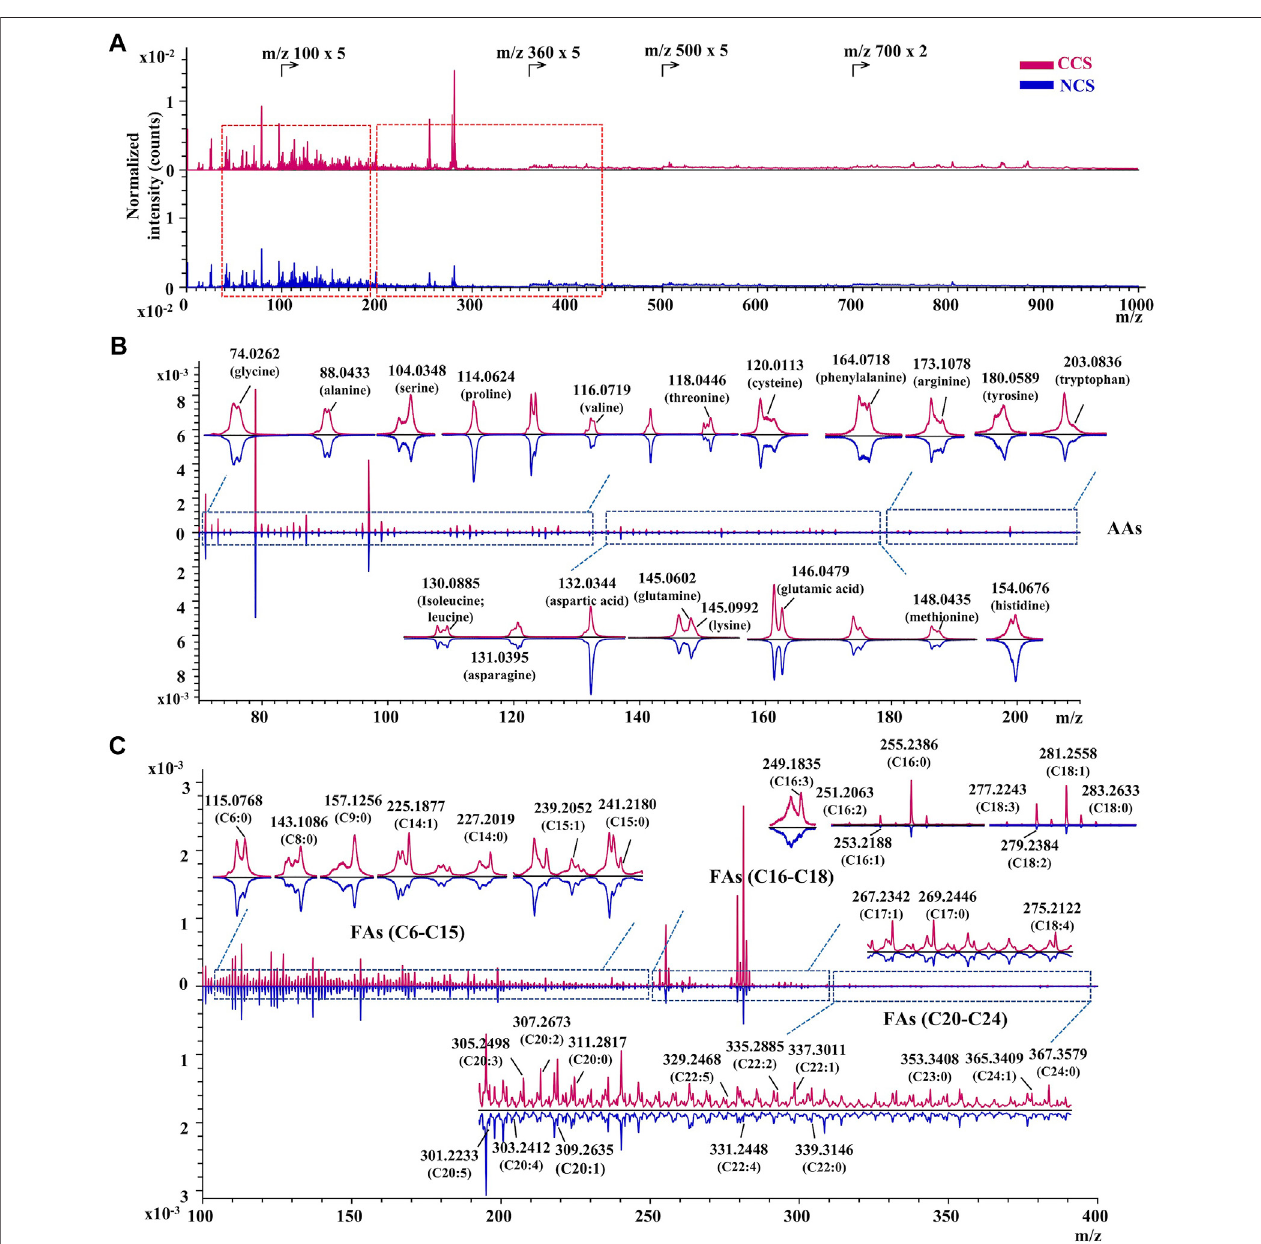
FIGURE 4 | The TOF-SIMS spectra of CCS and NCS samples in negative mode. (A) The representative spectra of CCS (No. 4 in red) and NCS (No. 14 in blue) samples. (B) Identi fi cationofaminoacids(AAs)inthemagni fi edregionwithm/zvaluefrom70to210. (C) Assignmentoffattyacidsinthemagni fi edregionwithm/zvalue from 100 to 400. The TOF-SIMS spectra were normalized by